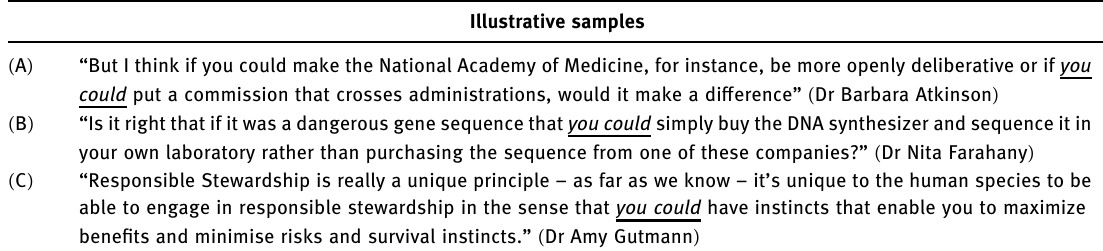
Table 25: Concordance extract: “ You could ” in Commission Women Data set